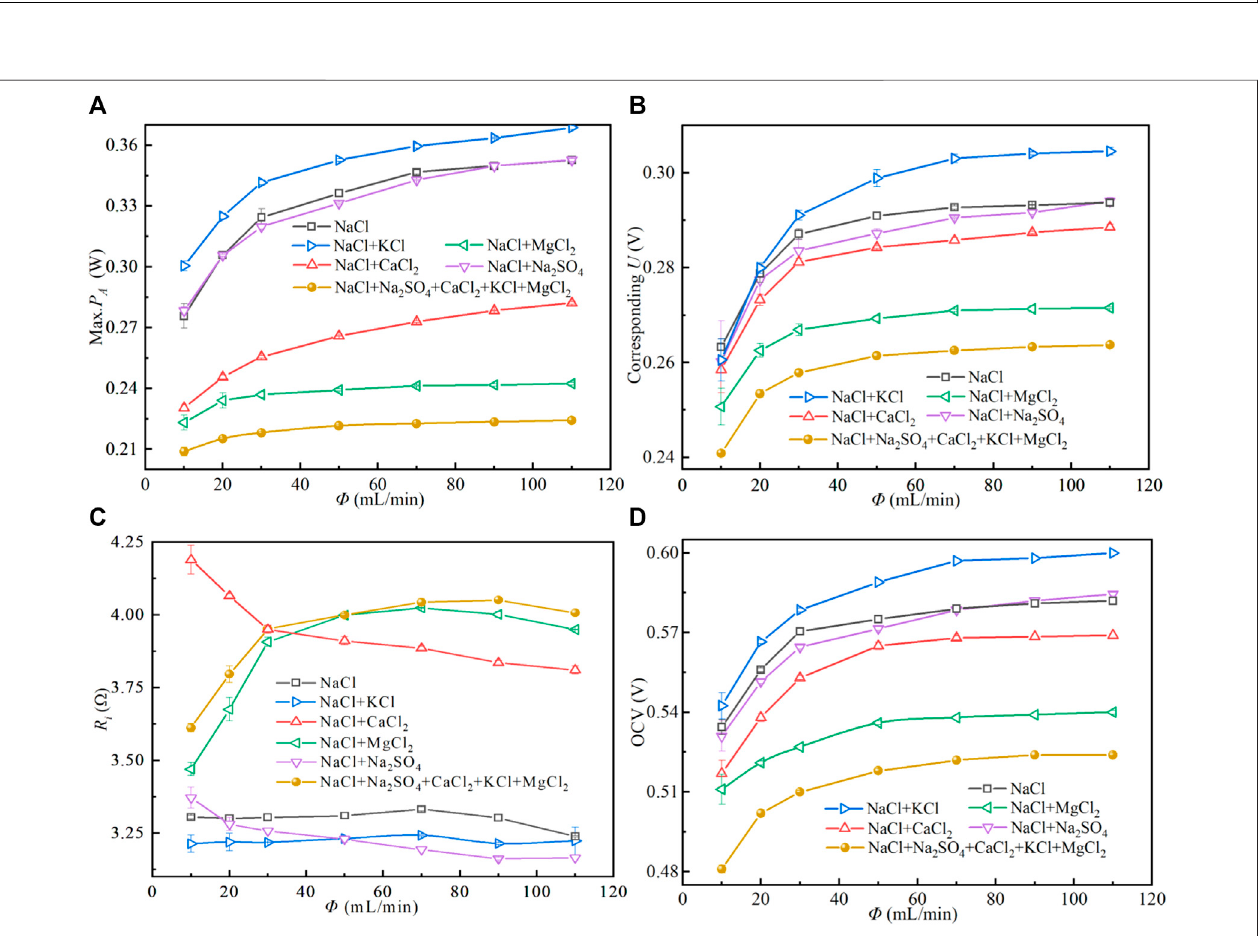
FIGURE 3 | Performance variation of the RED stack with the fl ow rate ( Φ ). Feed temperature is set as 19 ° C and concentrations of trace ions are as same as that in Figure 2 .